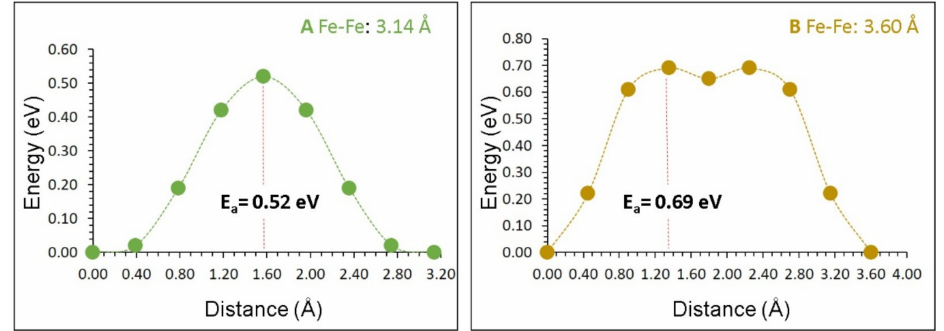
Figure 4. Two di ff erent energy profiles (as shown in Figure 3) of Fe vacancy hopping between two adjacent Fe sites in FeTiO 3 . Letters A and B are Fe-Fe local hops as shown in Figure 3.